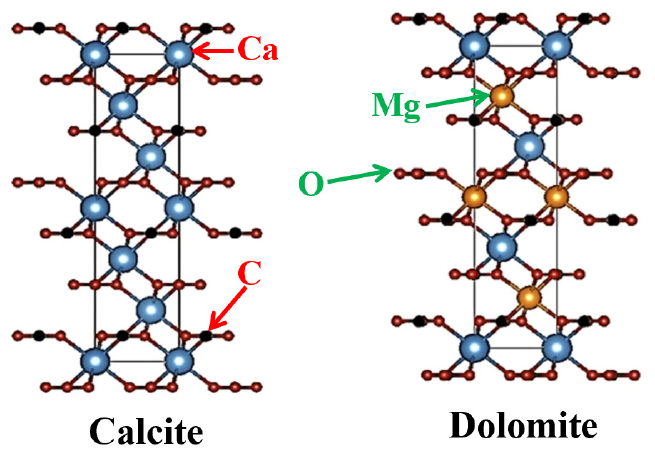
Figure 13. The structure models of carbonate and silicate. Reprinted with permission from Ref. [110].